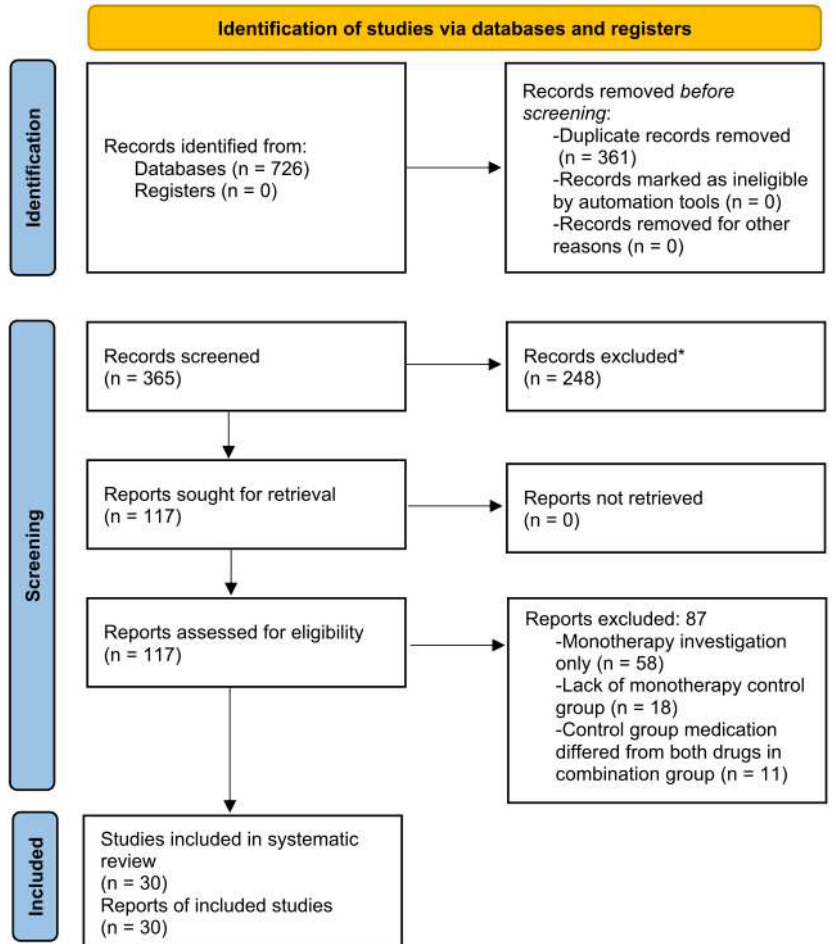
Figure 1. PRISMA flow diagram for systematic review procedure. * Records were manually screened with no automation tools used.